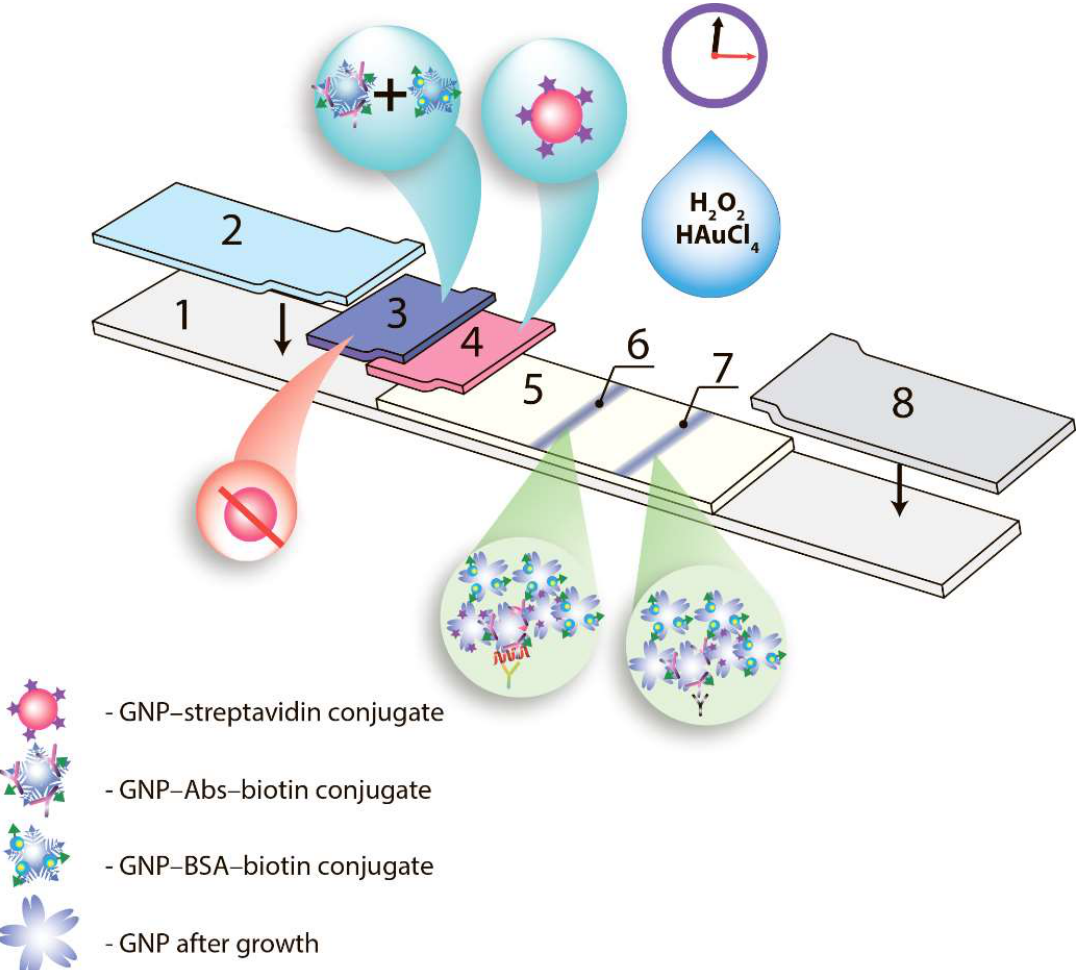
Figure 1. Scheme of test strip for ICA with triple enhancement: 1—plastic support, 2—sample pad, 3—pad with mixture of GNFs conjugates with biotinylated proteins, 4—pad with sGNP-streptavidin conjugate, 5—working membrane, 6—analytical zone, 7—control zone, 8—absorbent pad.